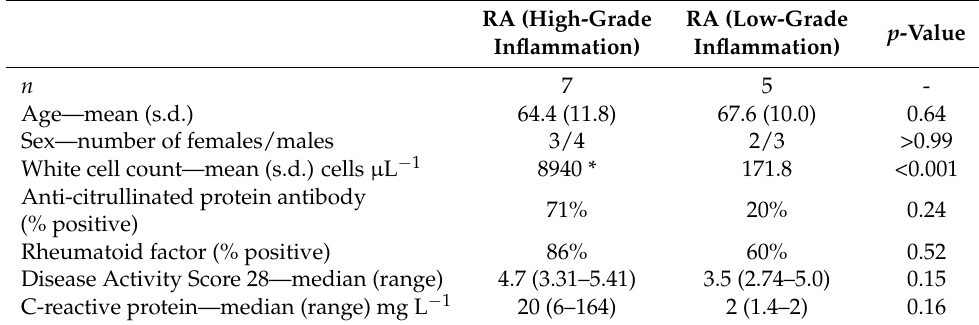
Table 1. Summary of patient details and clinical parameters.